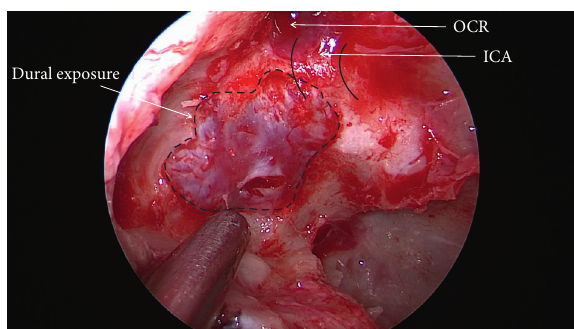
Figure 4: Exposure and opening of the dura.